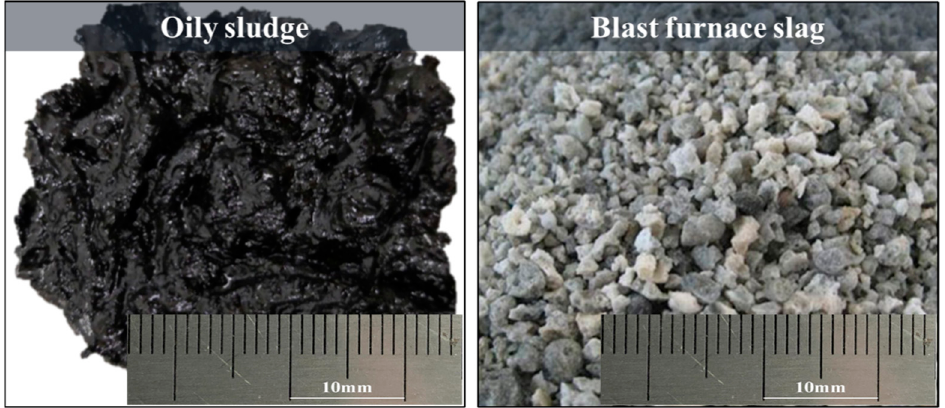
Figure 1. Samples of OS and BFS. Table 1. Chemical composition of BFS samples. Table 1. Chemical composition of BFS samples.